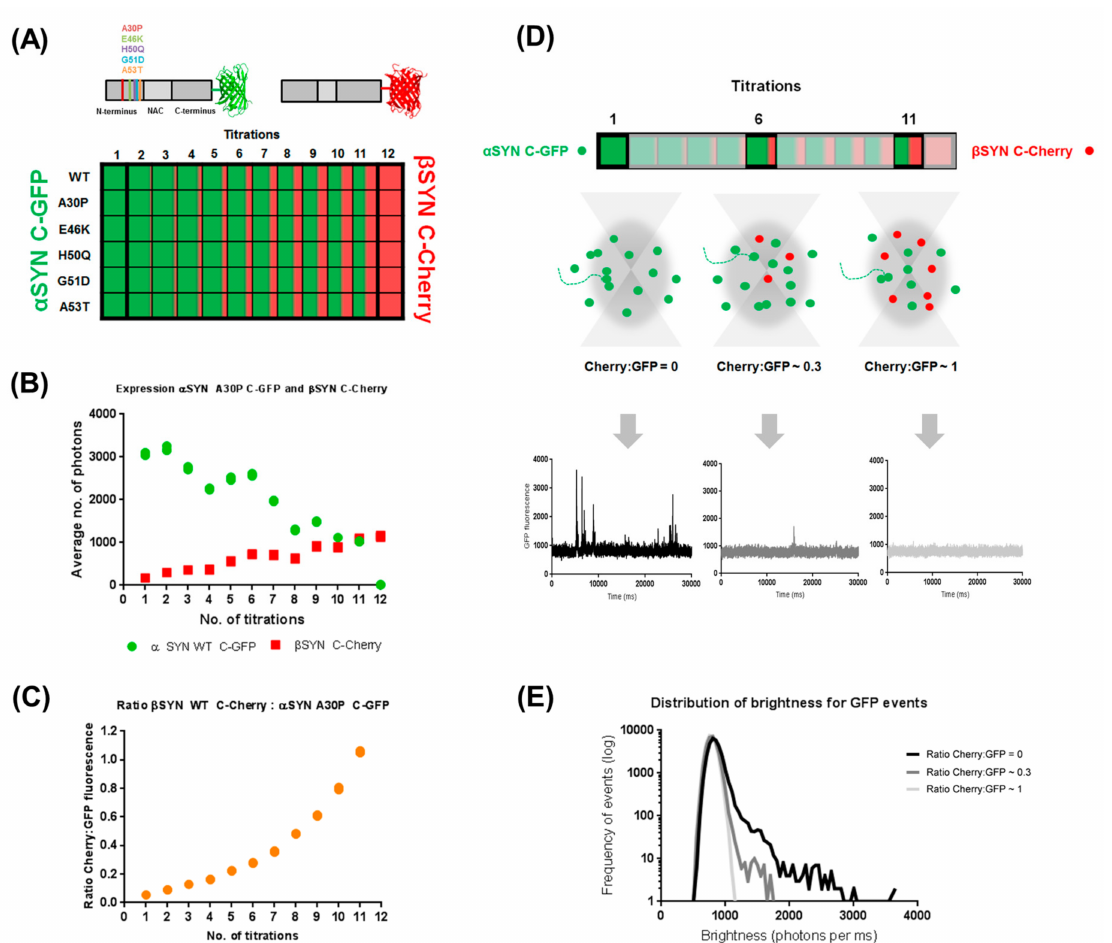
Figure 1. Controlled cell-free co-expression of α - and β -synucleins allows the investigation of their co-oligomerization dynamics. ( A ) Experimental layout for controlled co-expression of C-sGFP-tagged α -Synucleins (WT and five PD-related pathological mutants A30P, E46K, H50Q, G51D and A53T) and C-mCherry-tagged β -synuclein WT. All proteins were expressed in LTE. ( B , C ) This experimental layout allows us to accurately control the expression levels of sGFP- and mCherry-tagged proteins and their ratio. ( D ) This translates into different relative amounts of proteins being detected as they diffuse in and out of confocal volume, creating different GFP-fluorescent time traces for each titration between α - and β -synuclein (see examples of titrations 1, 6 and 11). ( E ) Analysis of these traces as a function of brightness (photons per ms) shows the effect of β -synuclein on the oligomerization propensity of α